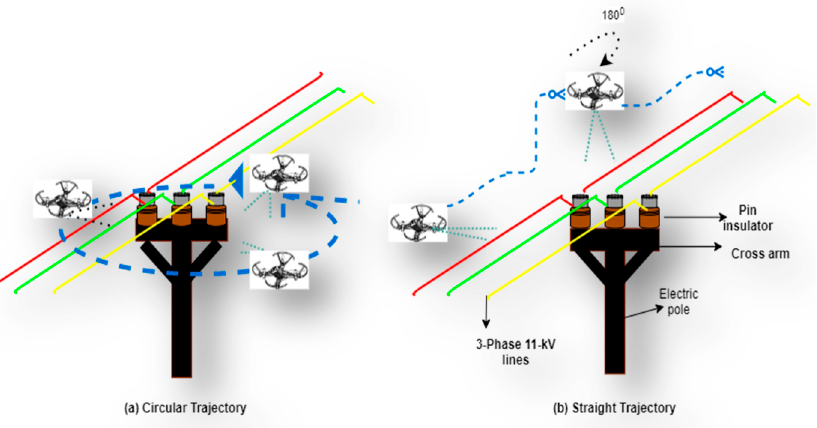
Figure 13. Flightpath strategies for the UAV for inspection of the insulators mounted on an electric pole. ( a ) Presenting a circular flight strategy ( b ) Presenting a straight flight path